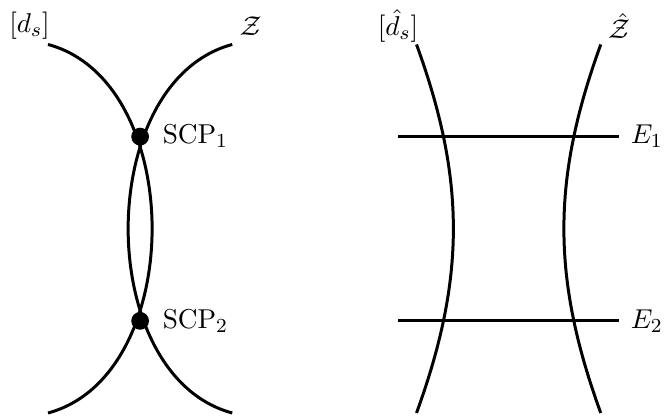
Figure 16 . Left: depiction of SCPs at the two simple intersection points of the two divisors [ d s ] and ; right: intersection points separated by two blow-up divisors E 1 ; 2 Z